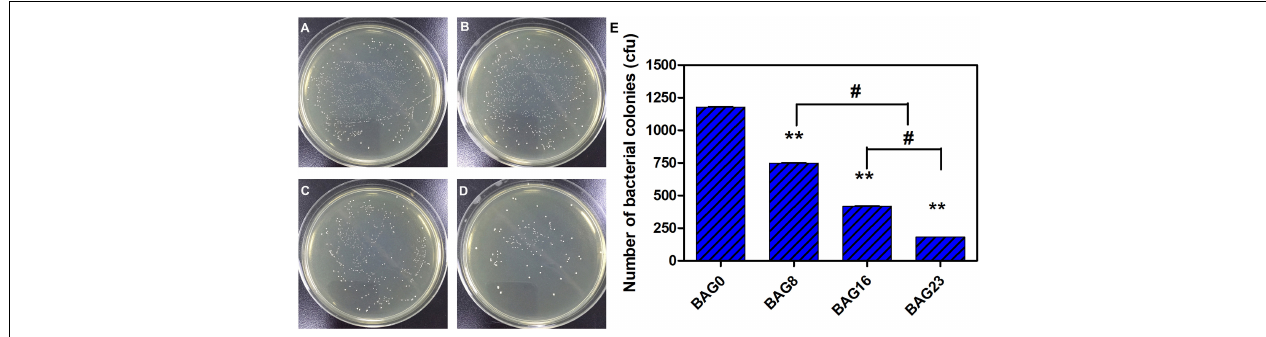
FIGURE 5 | Direct antibacterial effect of modified composite resin with different mass fractions of BAG particles. (A–D) Representative gross images of S. mutans seeded on the BHI agar plate. (A) BAG0 group. (B) BAG8 group. (C) BAG16 group. (D) BAG23 group. (E) Bar graph shows quantification and statistical data of colony-forming units (CFUs) of bacterial colonies after different treatments. Data are shown as mean ± SEM, n = 3. BAG0 indicates composite resin without BAG; BAG8 indicates composite resin with 8 wt% BAG; BAG16 indicates composite resin with 16 wt% BAG; BAG23 indicates composite resin with 23 wt% BAG. ** p < 0.01 vs. control. # p < 0.05 significant difference as compared